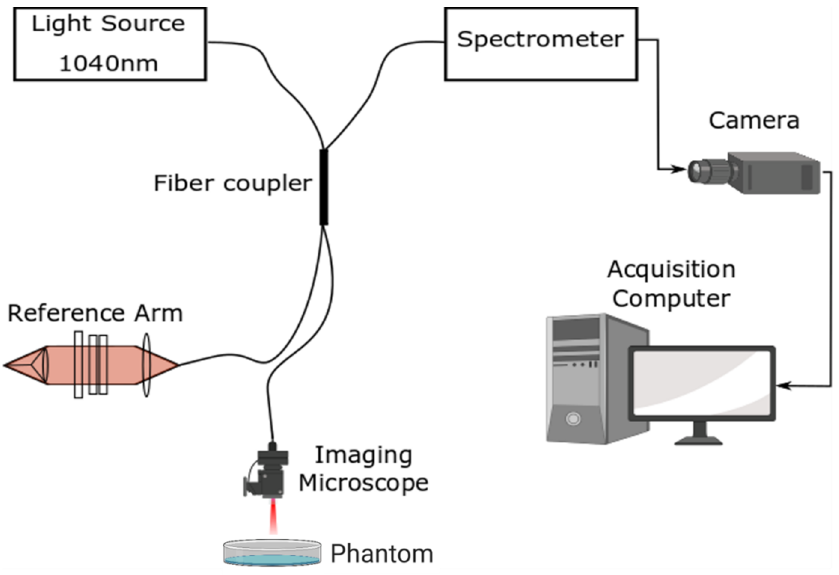
gelatin solution (1); diverse diameter of PBs (2), their volume differences in the solution (3) and scatterer RIs (4).